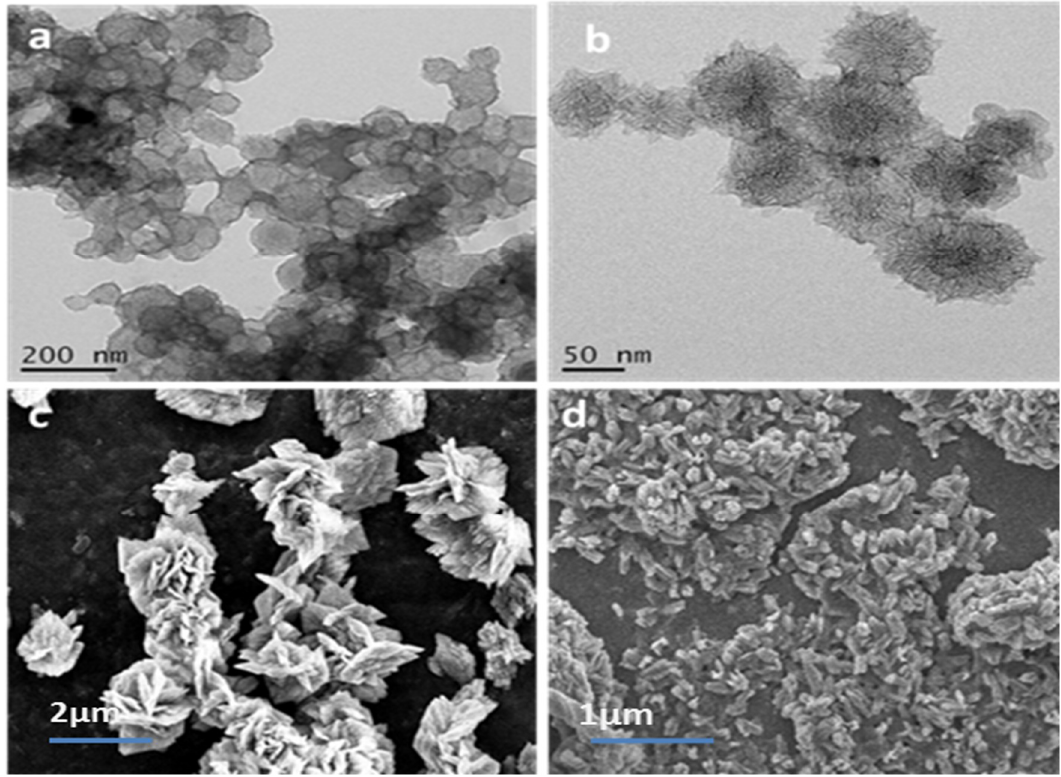
Figure 1. HR-TEM images of HFCNH under ( a ) low and ( b ) high magnification; ( c ) SEM images of HFCNH (1.8mg/mL); ( d ) dissociation of HFCNH in dilute concentration (0.1 mg/mL).